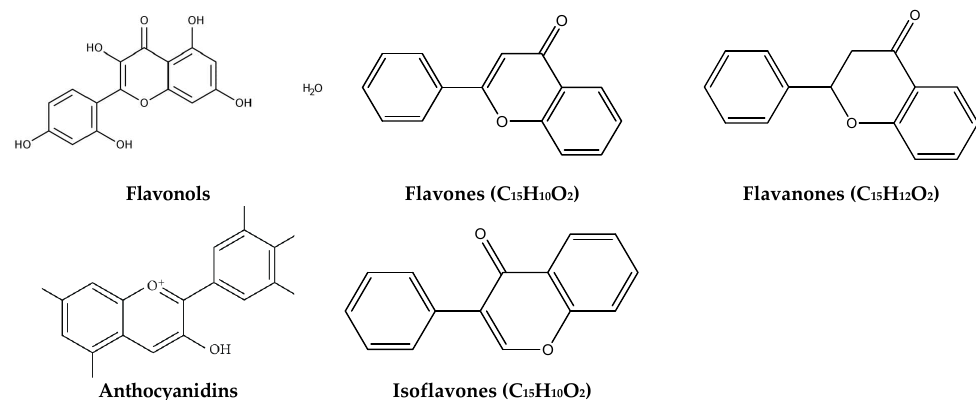
Figure 2. Chemical structures of some common plant flavonoids. Table 2. Some common plant